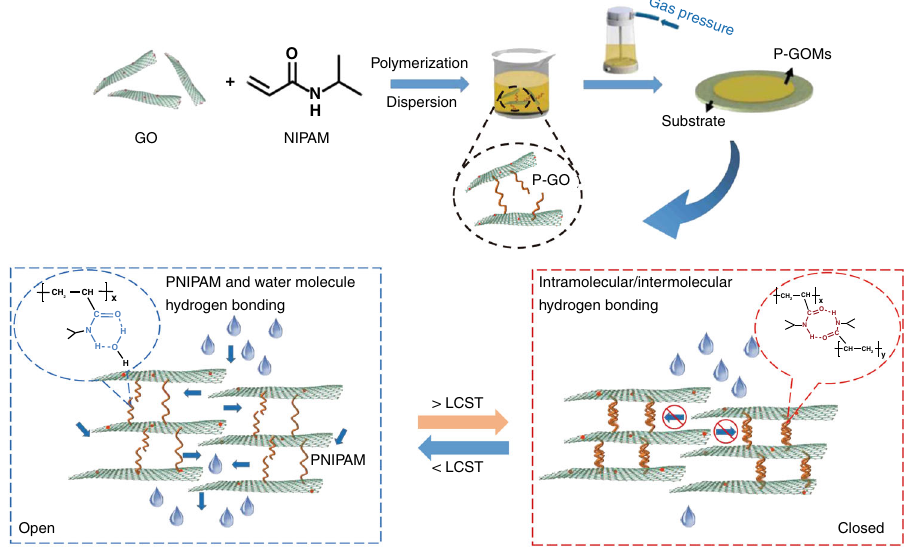
Fig. 1 Fabrication process of the temperature-responsive membrane and its water gating property. N -isopropylacrylamide (NIPAM) monomers polymerize on graphene oxide (GO) sheets to form PNIPAM-grafted GO (P-GO). Then P-GO assembles into PNIPAM covalently grafted GO membranes (P-GOMs) through pressure-driven fi ltration of their aqueous dispersion. The water permeance of P-GOMs could be regulated via the environmental temperature ( T ). P-GOMs have a large water permeance when T is below its lower critical solution temperature (LCST) because of the expanded water fl ow channel caused by the swollen PNIPAM chains. The water permeance decreases when T is above the LCST because of the narrowed channel of P-GOMs, which is caused by the shrink of PNIPAM